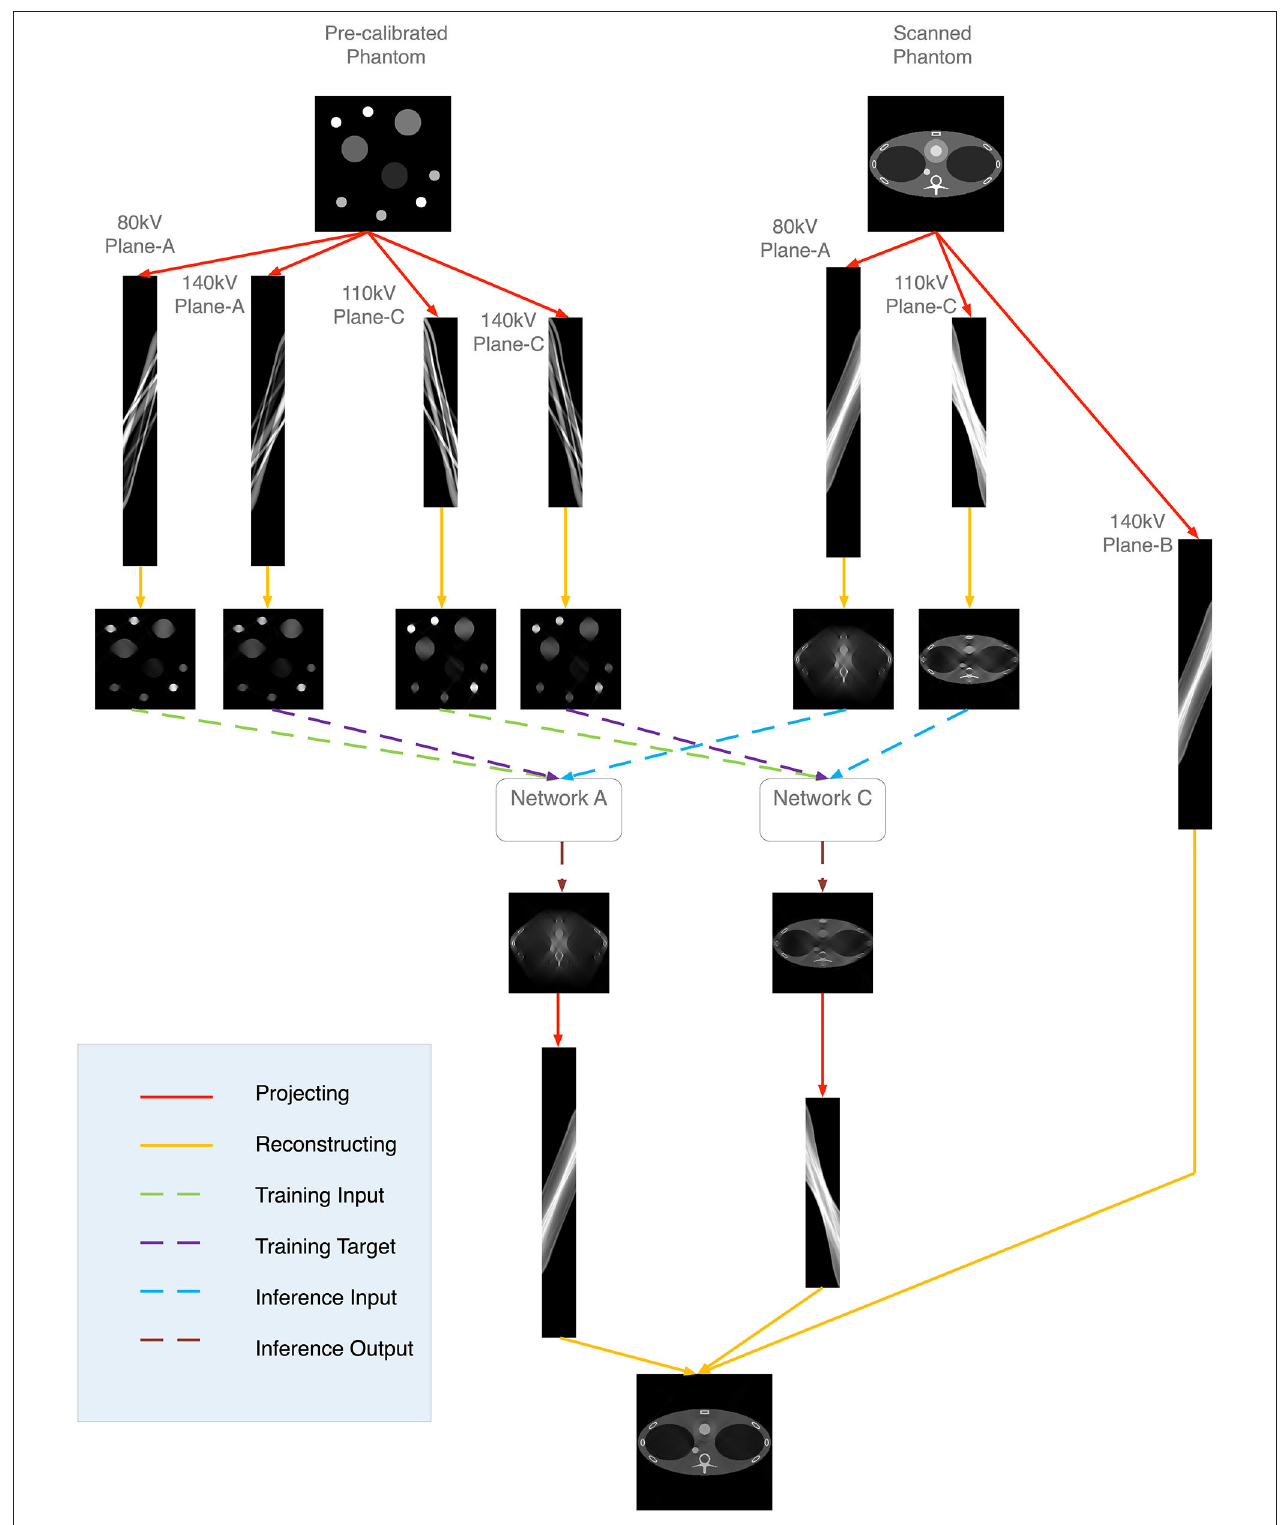
FIGURE 4 | The hybrid reconstruction flowchart of the 140 kV low-energy images.